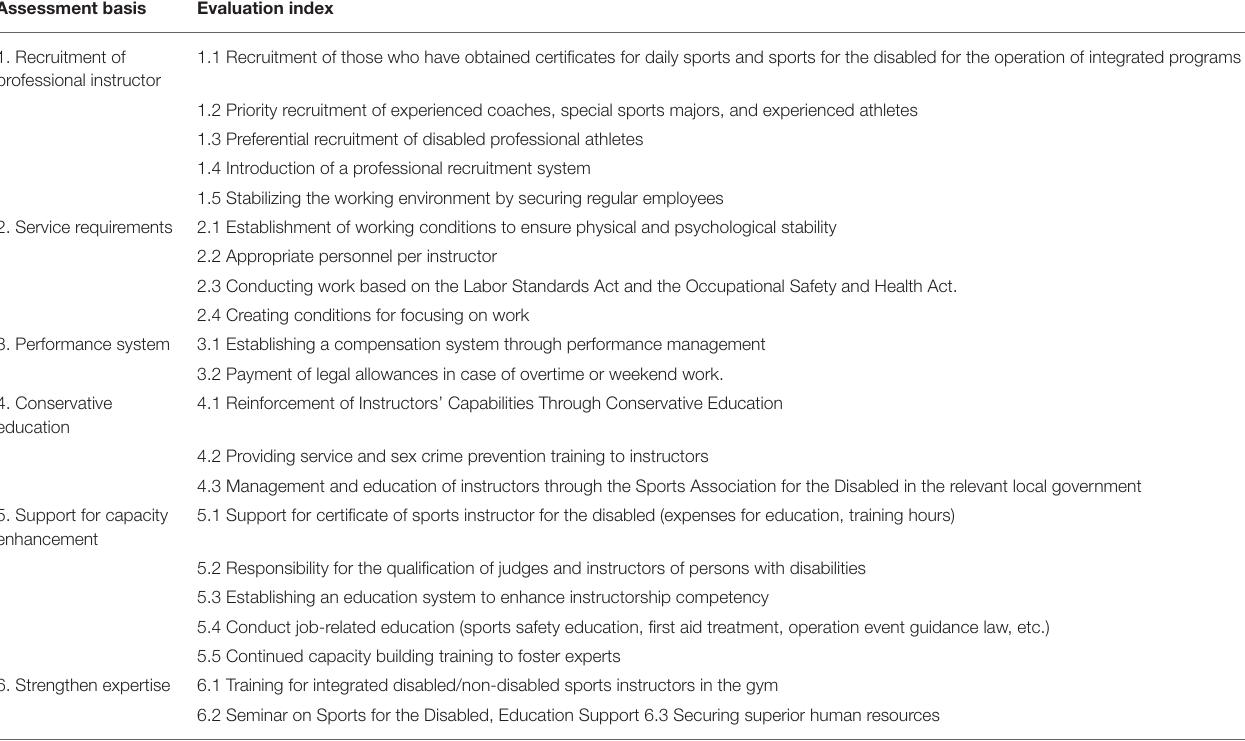
TABLE 4 | Classification of primary assessment criteria and evaluation indicators. Assessment